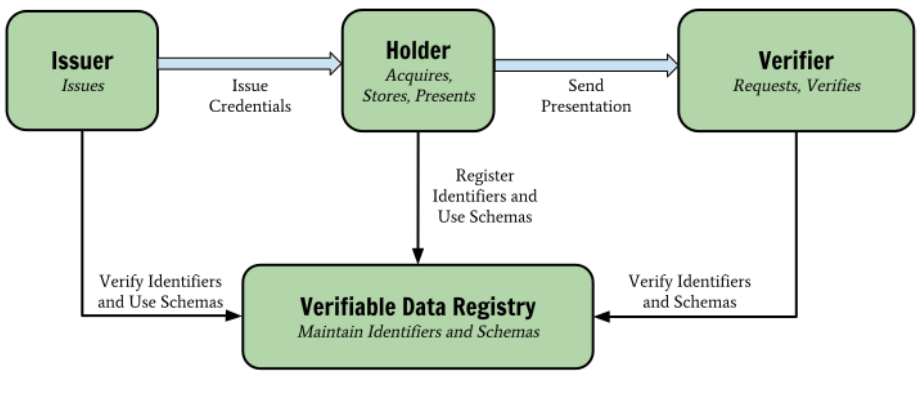
Figure 1. Verifiable Credential Roles